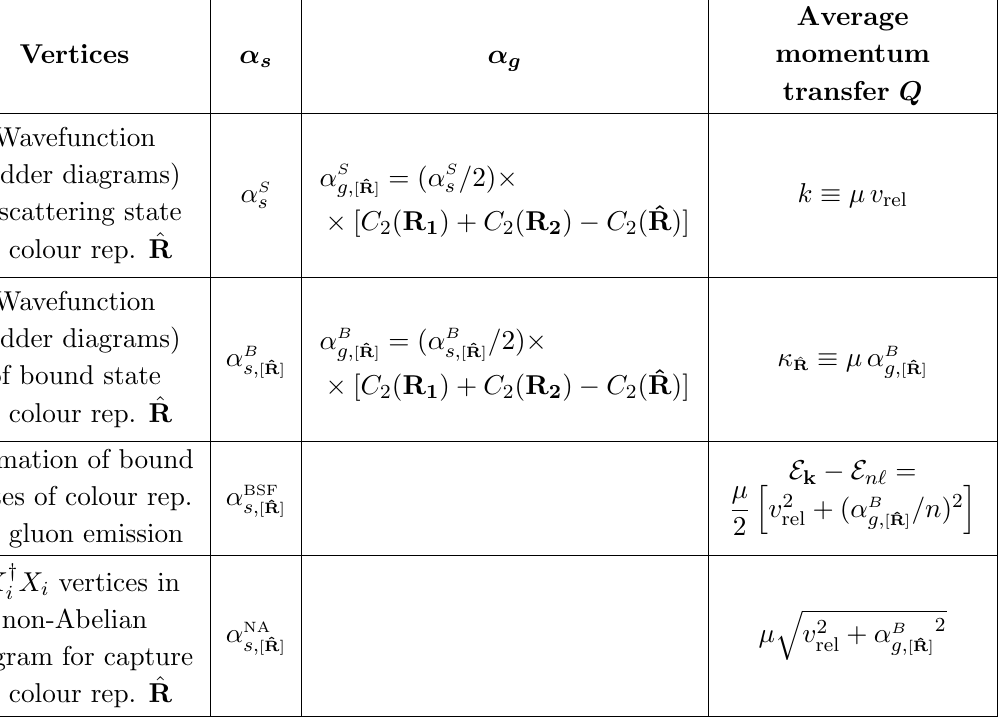
Table 1. The momentum transfer Q at which the coupling (cid:11) s ( Q ) is evaluated. With the ex- ception of (cid:11) S , the couplings depend on the representation ^R , as denoted; however, in our general s computations, we shall often omit the representation index, for